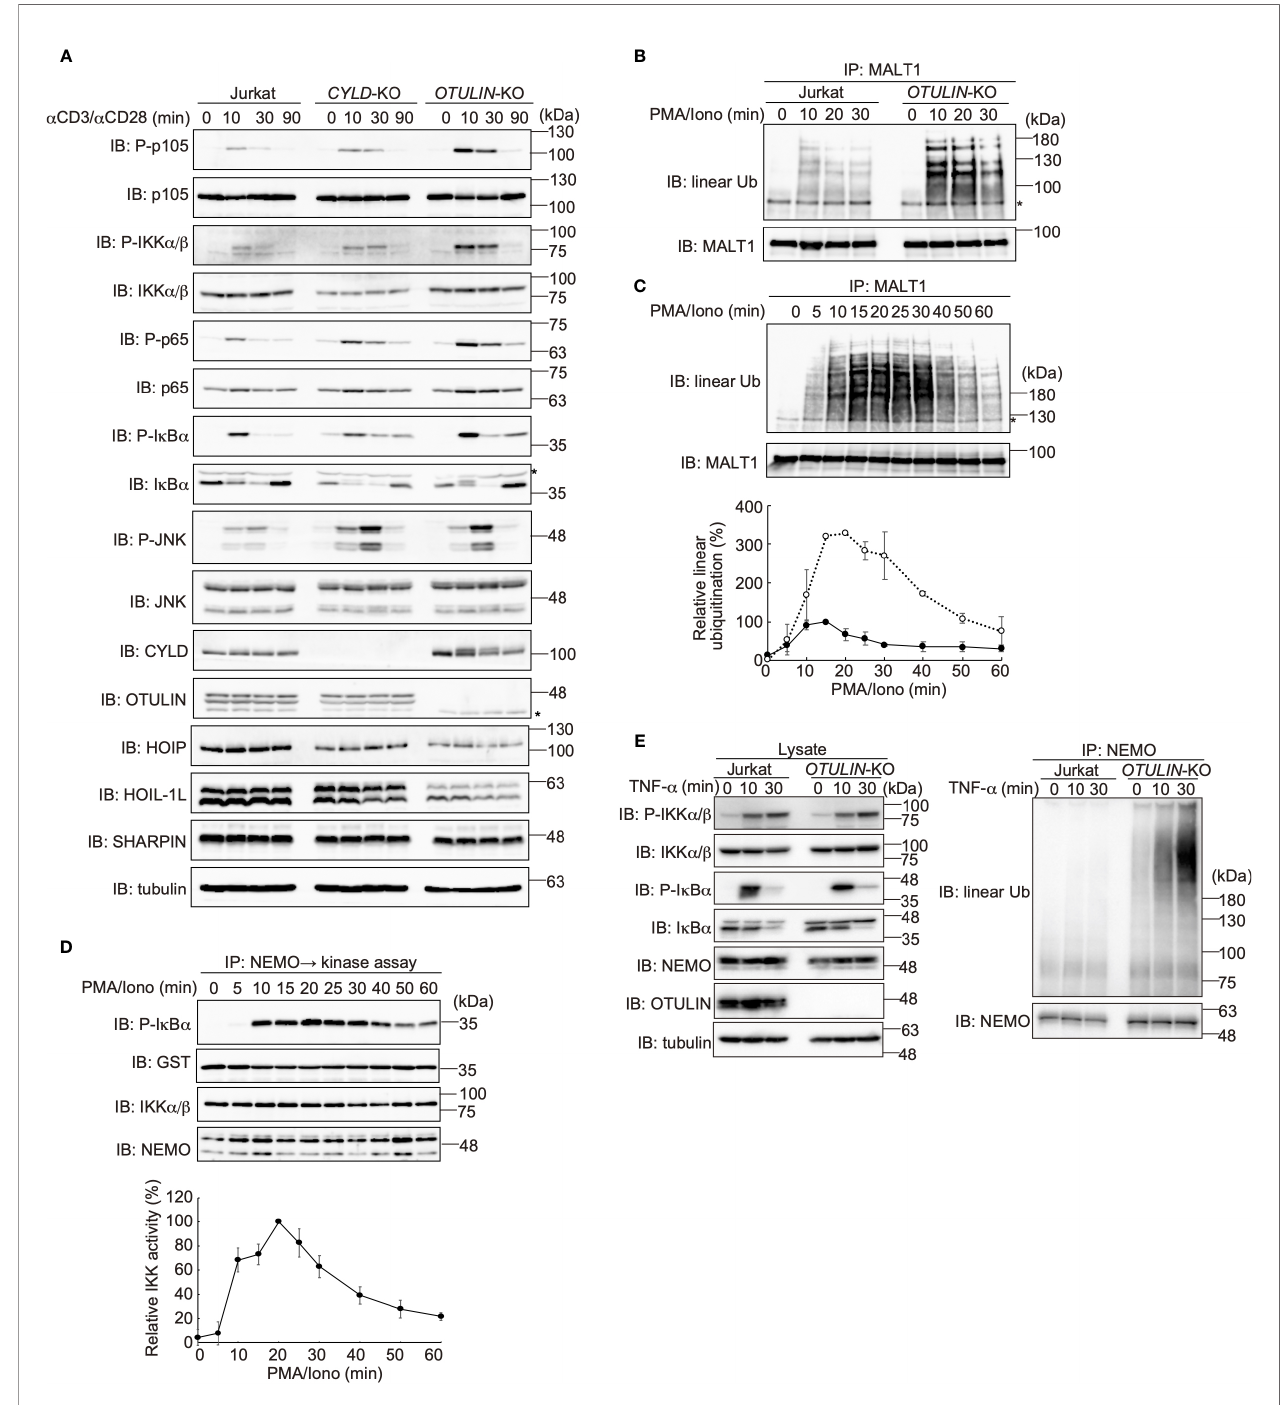
FIGURE 5 | OTULIN predominantly downregulates TCR-mediated NF- k B activation in Jurkat cells. (A) Parental, CYLD -de fi cient ( CYLD -KO), and OTULIN -de fi cient ( OTULIN - KO) Jurkat cells were stimulated with 4 m g/ml each of anti-CD3 and anti-CD28 antibodies for the indicated time periods, and cell lysates were immunoblotted with the depicted antibodies. (B) Augmented linear ubiquitination of MALT1 in OTULIN -de fi cient cells. Parental and OTULIN -KO Jurkat cells were stimulated with 20 ng/ml PMA and 150 ng/ml ionomycin for the indicated time periods, and the linear ubiquitination of MALT1 was compared as in Figure 4A . (C) Semi-quanti fi cation of MALT1 linear ubiquitination in OTULIN -KO cells. OTULIN -KO cells were stimulated with PMA and ionomycin, and analyzed as in Figure 4A . Taking the maximum intensities of the linear ubiquitination of MALT1 in parental Jurkat cells as 100% ( closed circles ), the relative intensities of linearly ubiquitinated MALT1 in OTULIN -KO cells are indicated ( open circles ). Means ±SD ( n = 3). (D) Transient activation of canonical IKK in OTULIN -KO cells. OTULIN -KO cells were stimulated with PMA and ionomycin, and analyzed as in Figure 4E . (E) Enhanced linear ubiquitination of NEMO in OTULIN -KO cells upon TNF a treatment. Jurkat and OTULIN -KO cells were stimulated with 1 µg/ml TNF- a for the indicated time periods, and analyzed as in Figure 4C . (A – C) *; nonspeci fi c